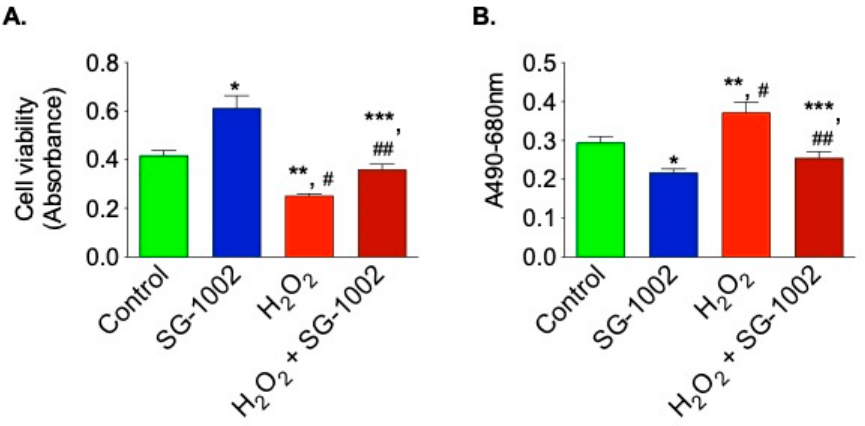
Figure 7. SG-1002 decreases oxidative stress-induced cellular death and cytotoxicity in HL-1 cardiac muscle cells. HL-1 cells were incubated with specific reagents as described in Materials and Methods. Cell viability ( A ) and cytotoxicity ( B ) were determined by using MTT and LDH cytotoxicity assays, respectively. * and **, p < 0.05 vs. control; #, p < 0.05 SG-1002 vs. H 2 O 2 ; ##, p < 0.05 H 2 O 2 vs. SG-1002 + H 2 O 2 ; ***, p < 0.05 SG-1002 vs. SG 1002 + H 2 O 2 (Anova) (n = 3).